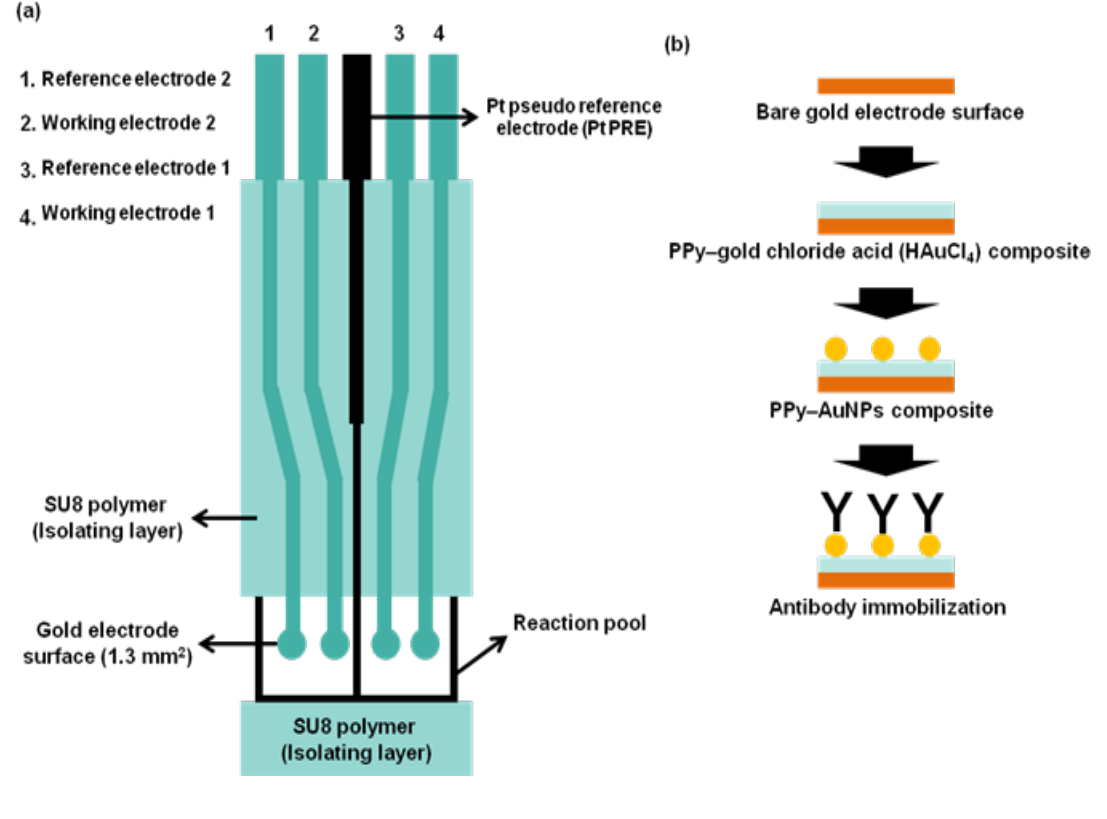
Figure 4. Schematic diagram of the ISFET-based monitoring via conformational changes in MBP [49]. Upon binding to maltose, MBP undergoes a structural transition into closed conformations, resulting in decrease of drain